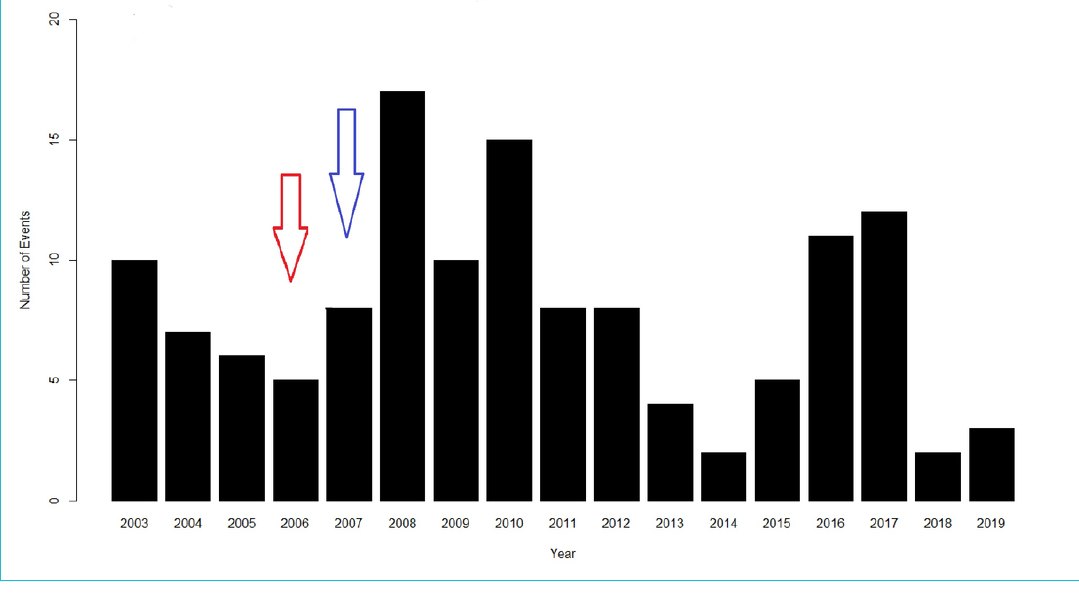
Figure 2: Number of events by year n = 133. The red arrow indicates implementation of the critical incident reporting system (CIRS) at the LUKS in 2006. The blue arrow represents arrival of a new head of the Department of Anaesthesiology in 2007.